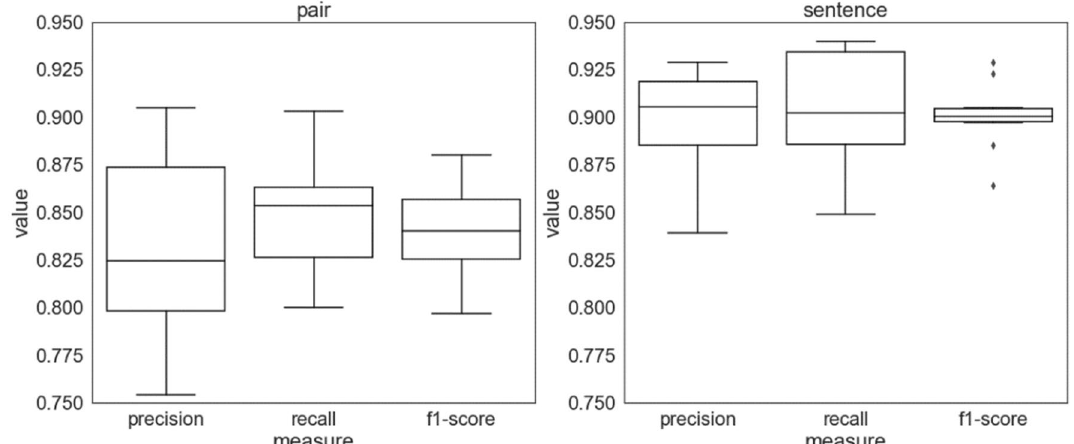
Figure 5. Performance of our method on bacteria-disease relation extraction. In tenfold cross validation, the mean precision was 0.832, the mean recall was 0.848, and the mean F-score was 0.839 for the pairs of bacteria and disease. For the sentences, mean precision was 0.898, the mean recall was 0.905, and the mean F-score was 0.901. Confidence threshold = Method